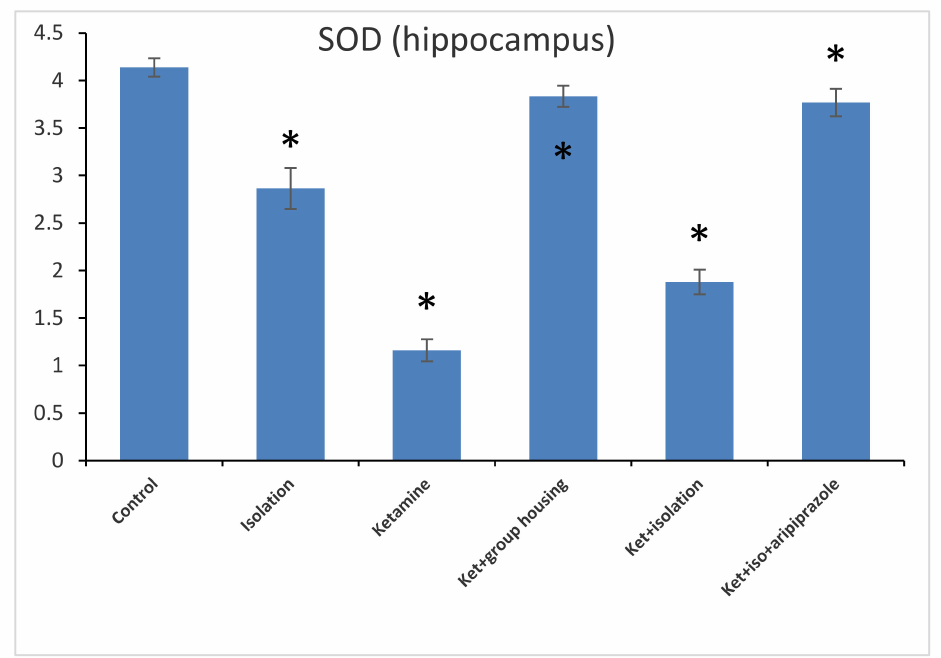
Figure 9. The effects of social isolation, ketamine, combined ketamine and social isolation, and com- bined ketamine, social isolation, and aripiprazole treatment on SOD-specific activity in hippocampus brain samples (measured in U/mg of protein). The values are mean ± SD ( n = 7 per group). * Significantly different when compared to control group ( p < 0.05).